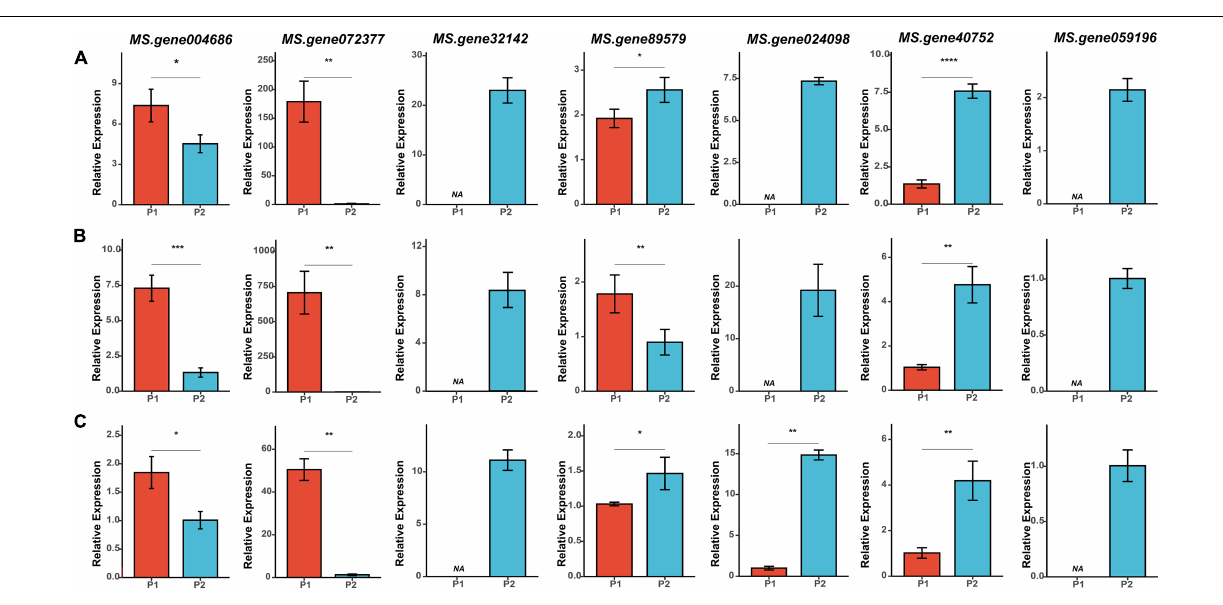
FIGURE 6 | qRT-PCR analysis of the seven candidate genes at three flowering stages in two parents. (A–C) Relative expression of the seven candidate genes at BS (budding stage), IFS (initial flowering stage), and FFS (full flowering stage), respectively. Asterisk symbols indicate significant differences between two parents ( t -test, * p < 0.05; ** p < 0.01; *** p < 0.001, **** P <